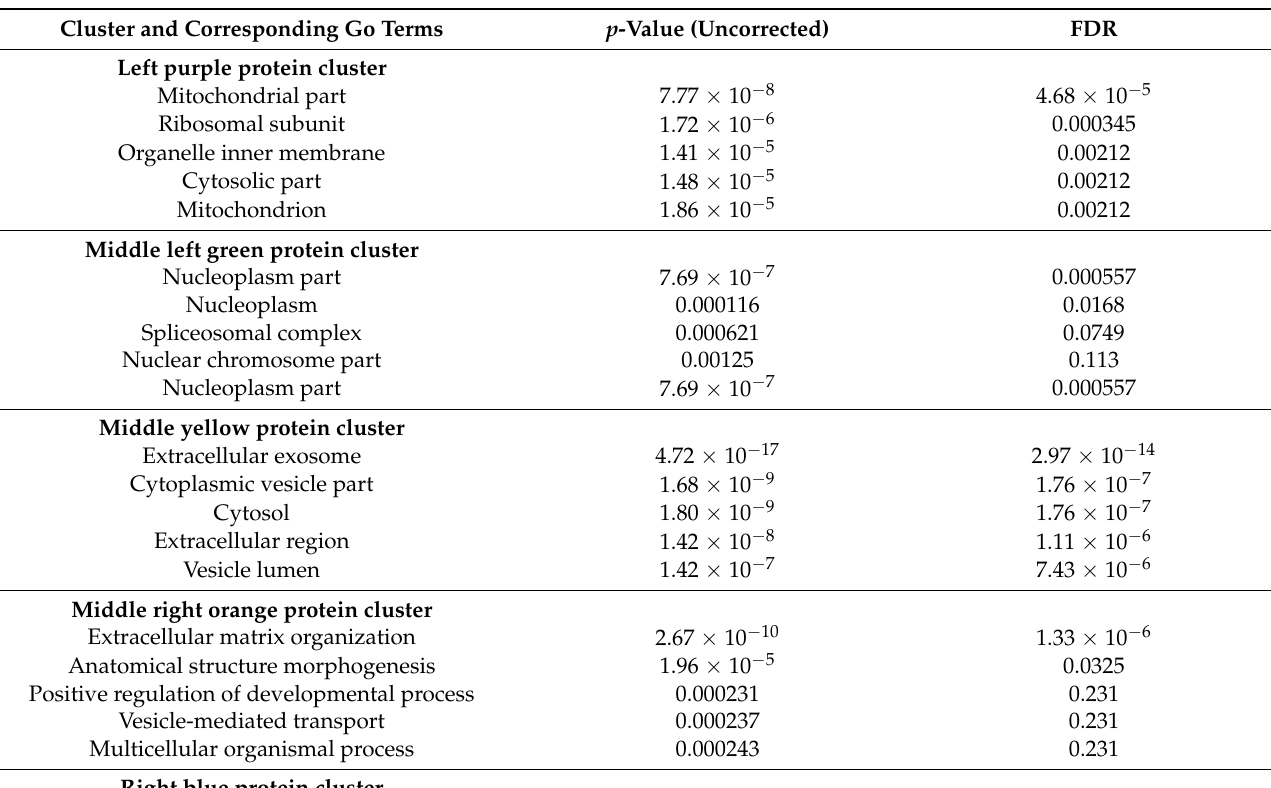
Table 3. Hierarchical clustering of AML patients based on the constitutive protein release profiles of their leukemic cells during in vitro culture. The table gives an overview of the most significant GO terms for each of the five identified protein clusters (see Figure 4, upper part indicating the protein clustering). For each of the five protein clusters, we present the five most significant GO terms (Cellular